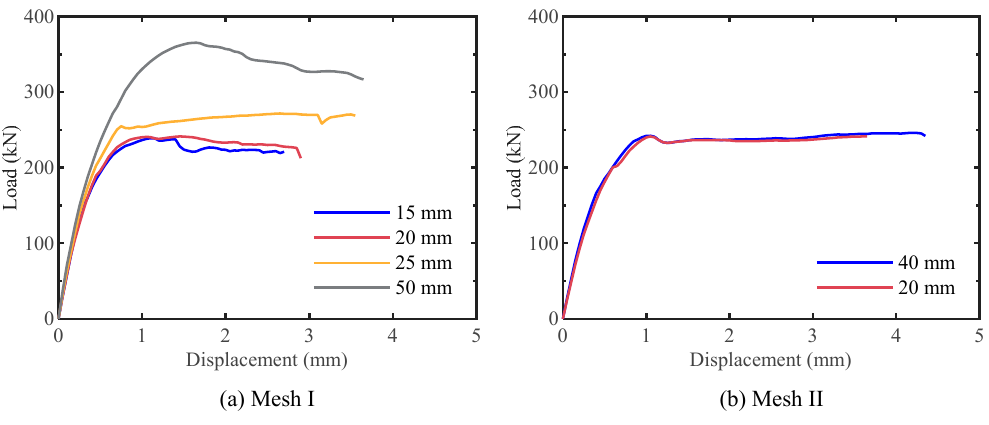
Figure 6. Mesh sensitivity analysis.